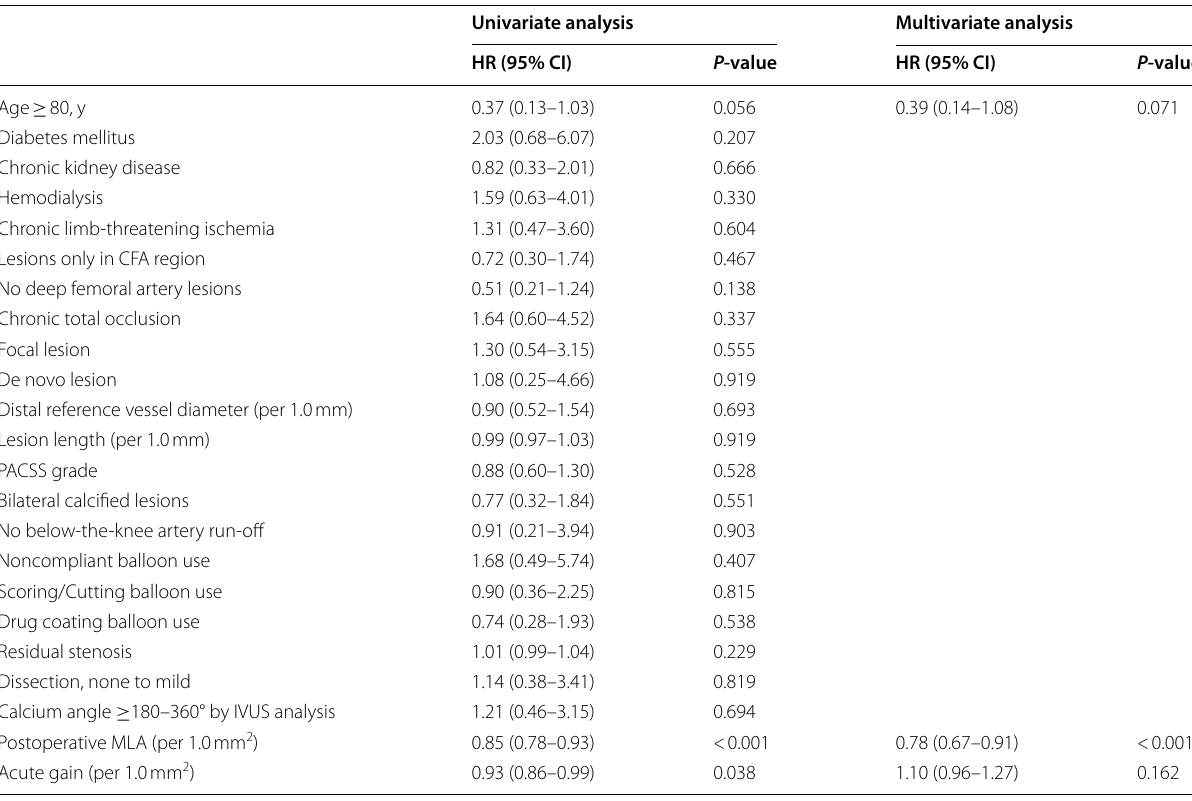
Data are presented as HR (95% CI) derived from the Cox proportional hazards regression model